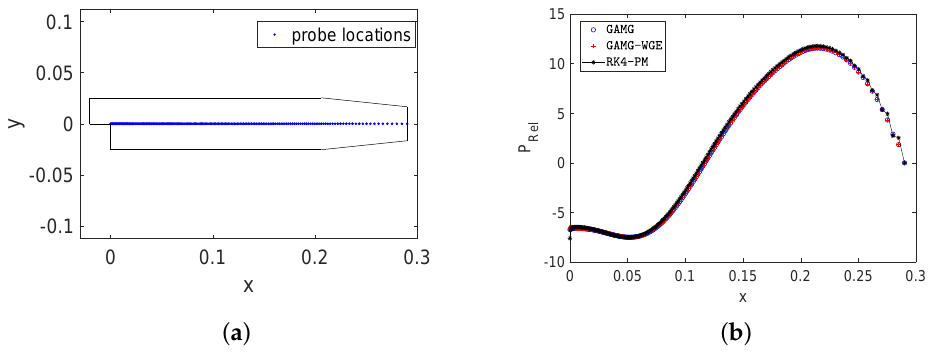
Figure 8. ( a ) The probe locations, and ( b ) the corresponding p Rel field at 0.3s using different methods in